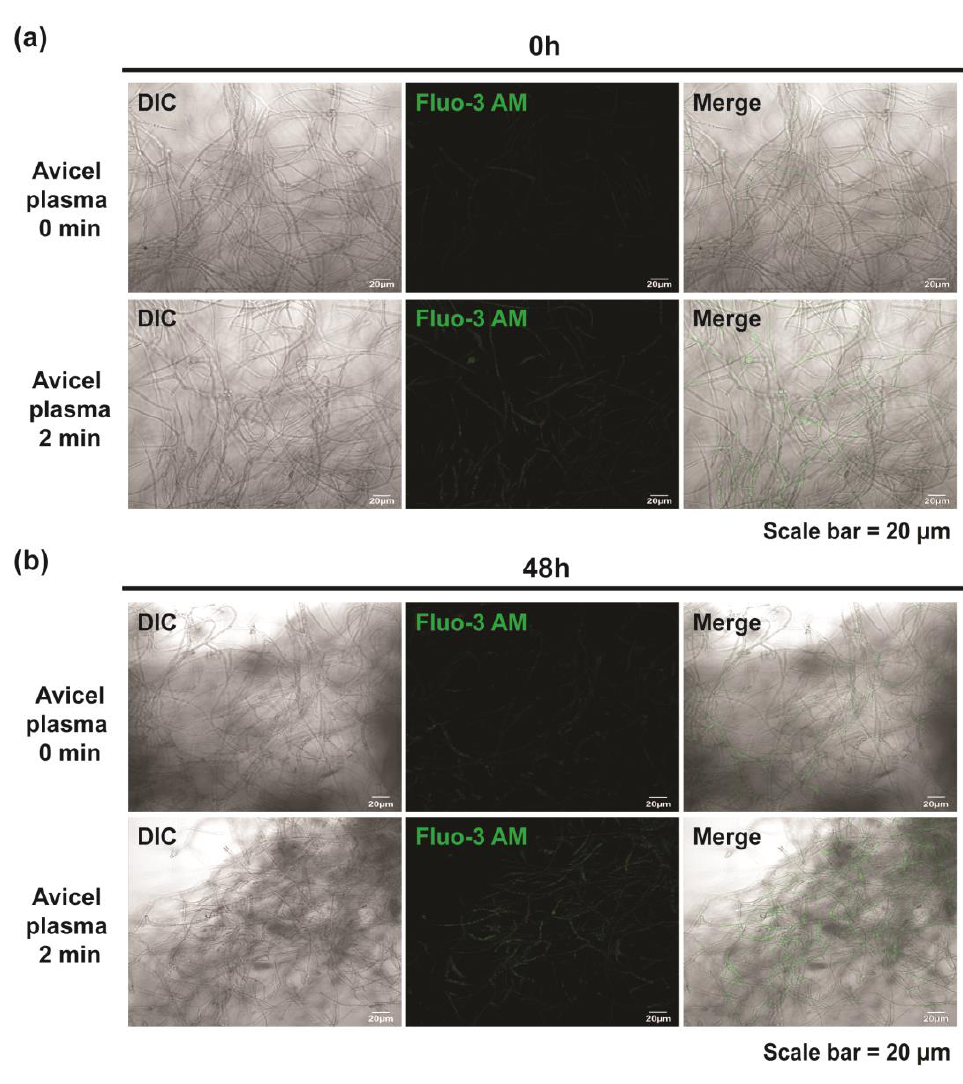
Figure 8. Assay for intracellular Ca 2+ levels using Fluo-3 AM in the fungal hyphae at 0 ( a ) and 48 h ( b ) after plasma treatment for 0 or 2 min in Avicel-containing media.